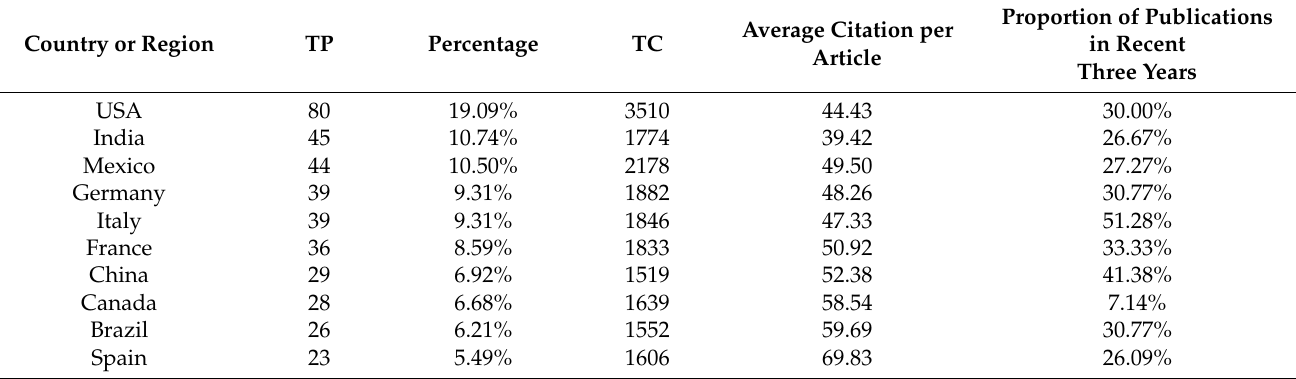
Table 1. Top 10 countries or regions in the number of publications.